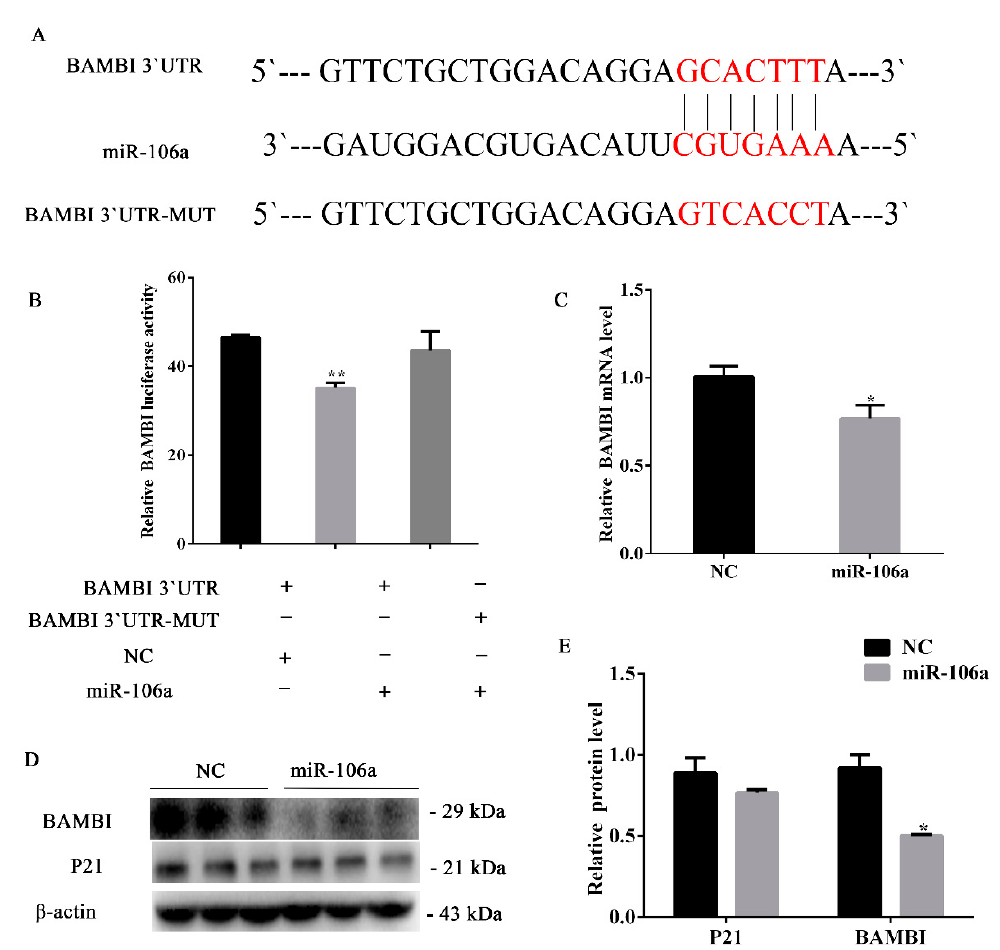
Figure 5. miR-106a can target BMP and activin membrane-bound inhibitor (BAMBI) instead of cyclin-dependent kinase inhibitor 1A ( p21) during adipogenic differentiation. (A) The target site of miR-106a within the porcine BAMBI mRNA 3 ′ UTR and mutational site of BAMBI 3 ′ UTR; (B) the dual-luciferase assay was performed by com-transfection of the miR-106a agomir and wild-type vectors or mutant vectors. Relative luciferase activity was represented by Renilla luciferase/firefly luciferase (RLUC/FLUC); (C) the relative BAMBI mRNA expression levels after treatment with an miR-106a agomir; (D) western blot analysis of p21 and BAMBI protein expression after treatment with an miR-106a agomir; (E) the quantification of p21 and BAMBI protein expression levels. Data are representative of the mean ± standard deviation of three independent experiments. * p < 0.05; ** p < 0.01.